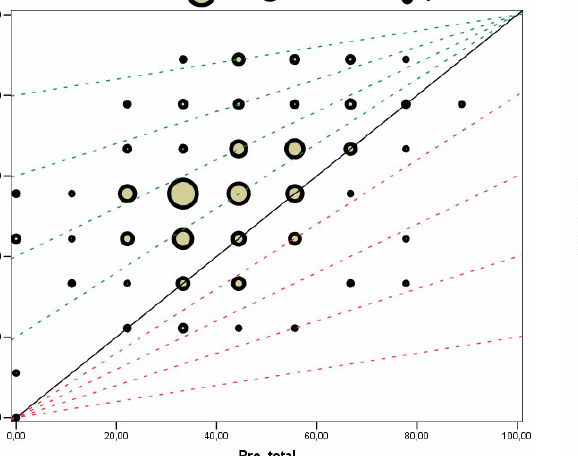
Figure 10. Gain results in questions 3 & 4, for both groups of students